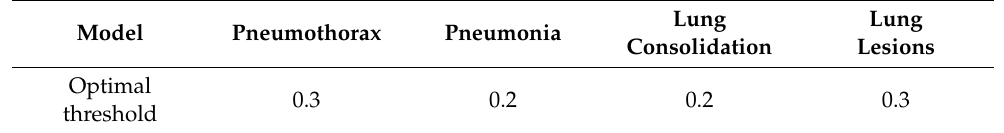
Table 3. Best thresholds for each